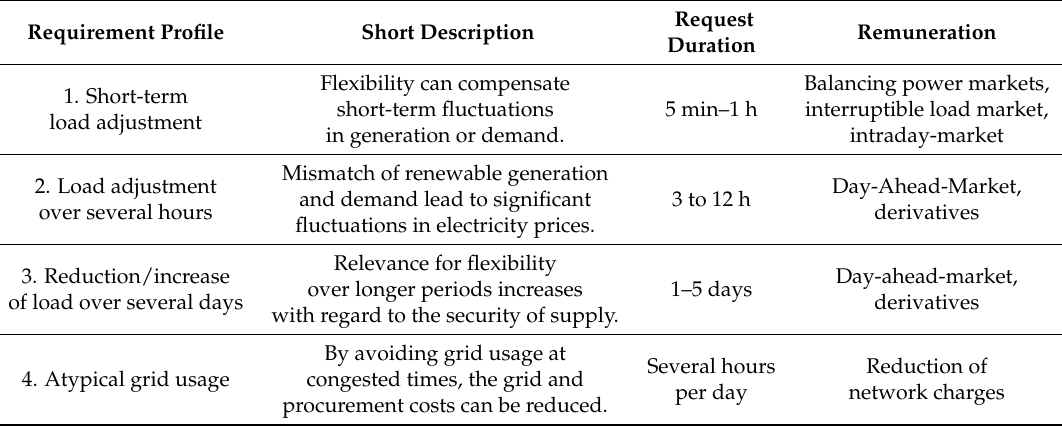
Table 1. Requirement profiles and potential remuneration for